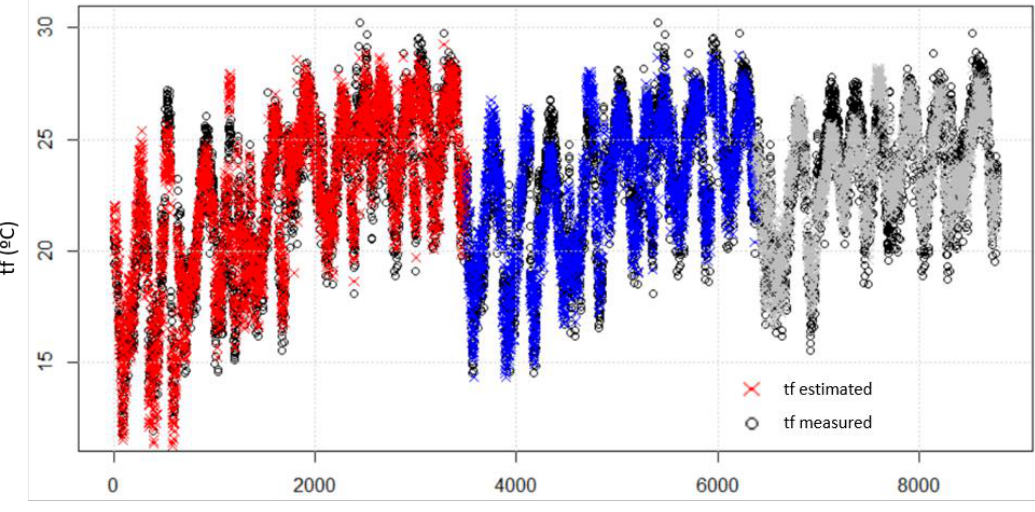
Figure 8. Final temperature comparison for di ff erent node lag steps as a function of node-to-node (red) and multi-node lag steps (blue represents two steps and gray represents three steps).